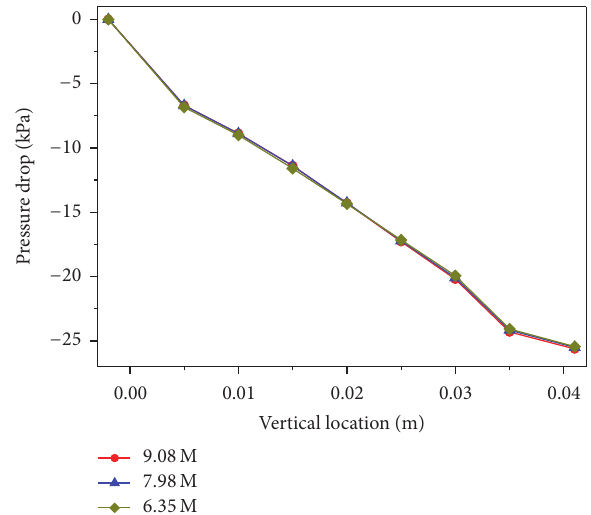
Figure 11: Analysis on pressure drop for 5 × 5 grid.